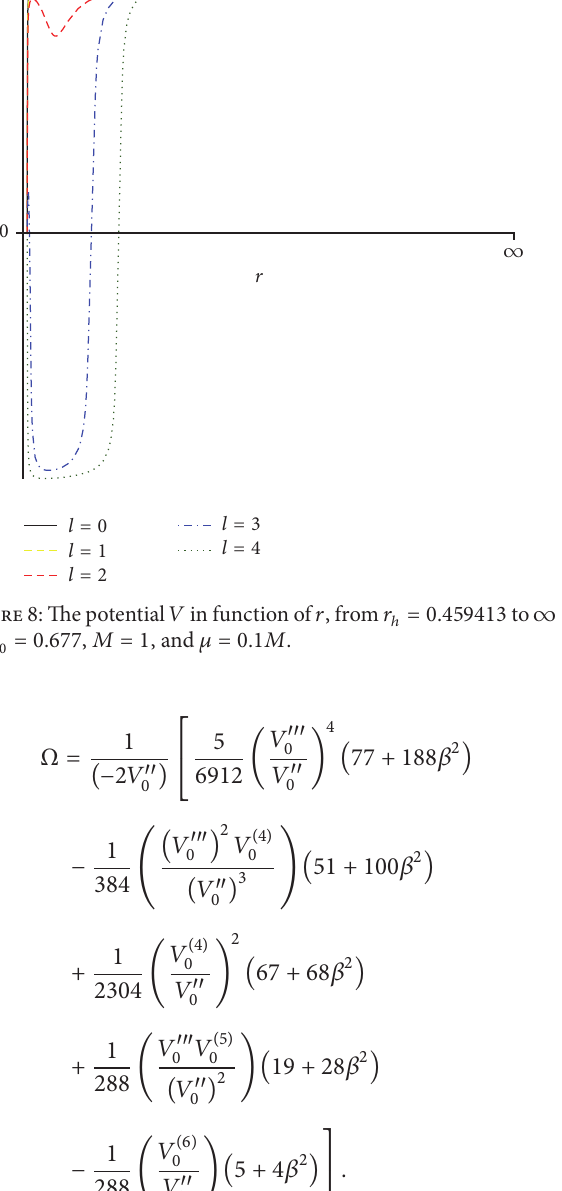
Table 1: Quasinormal modes of scalar perturbations for 𝛼 0 = 0.677 with 𝑀 = 1 and 𝜇 = 0 .